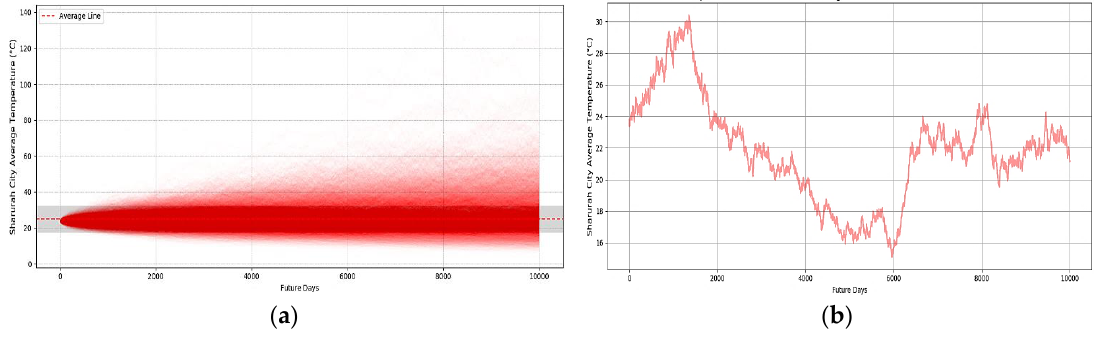
Figure 21. ( a ) Average daily temperature distributions for the south-west region, as predicted by MCS and BM, and ( b ) a one-day scenario for the temperature distribution prediction performance.